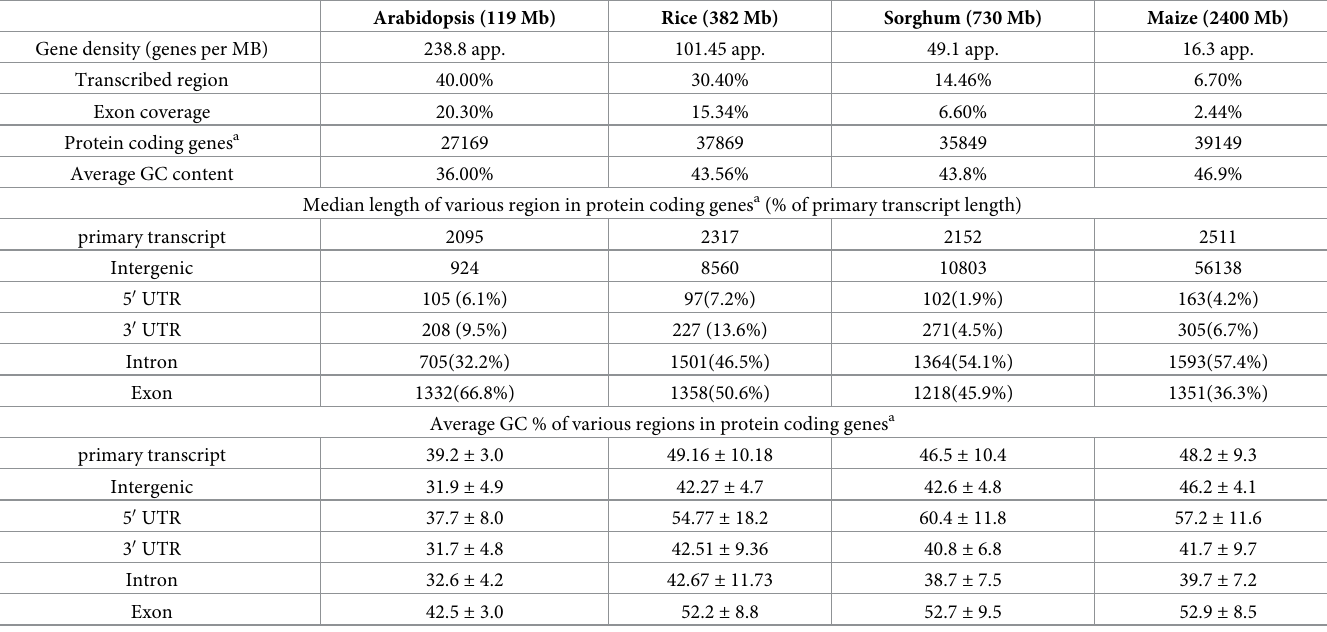
Table 1. Comparative statistics of various parameters of whole genome and gene architecture of arabidopsis, rice, sorghum and